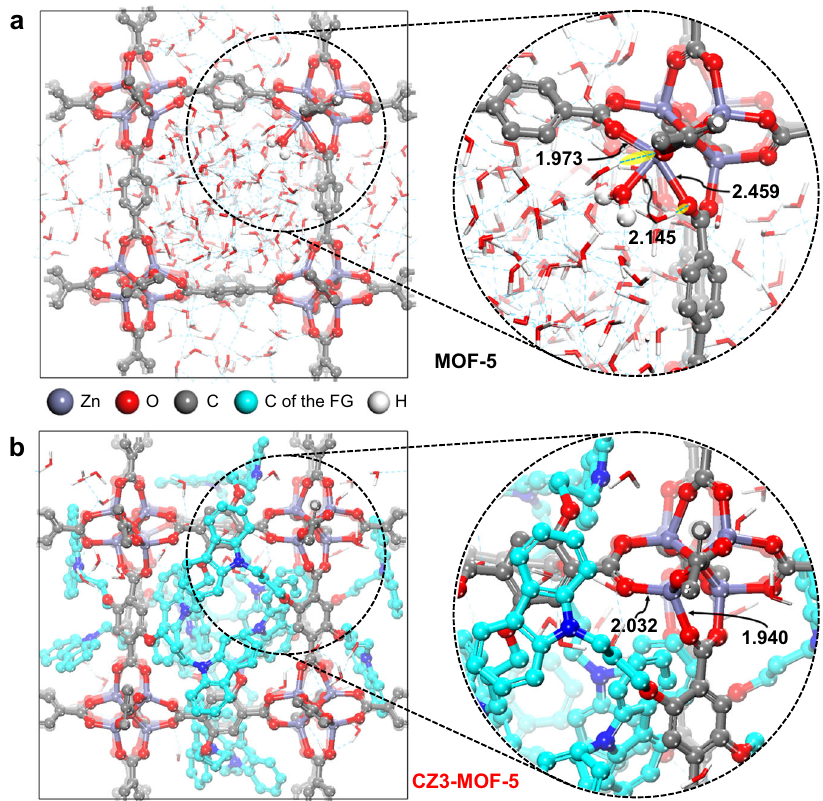
Fig. 6 Snapshots for the equilibrium state based on the DFTB molecular dynamics simulation after 100 ps. a MOF-5. b CZ3-MOF-5. The number of H 2 O molecules was determined with current density ~0.998 g mL – 1 in the periodic boundary condition. Non-essential hydrogens are not shown.